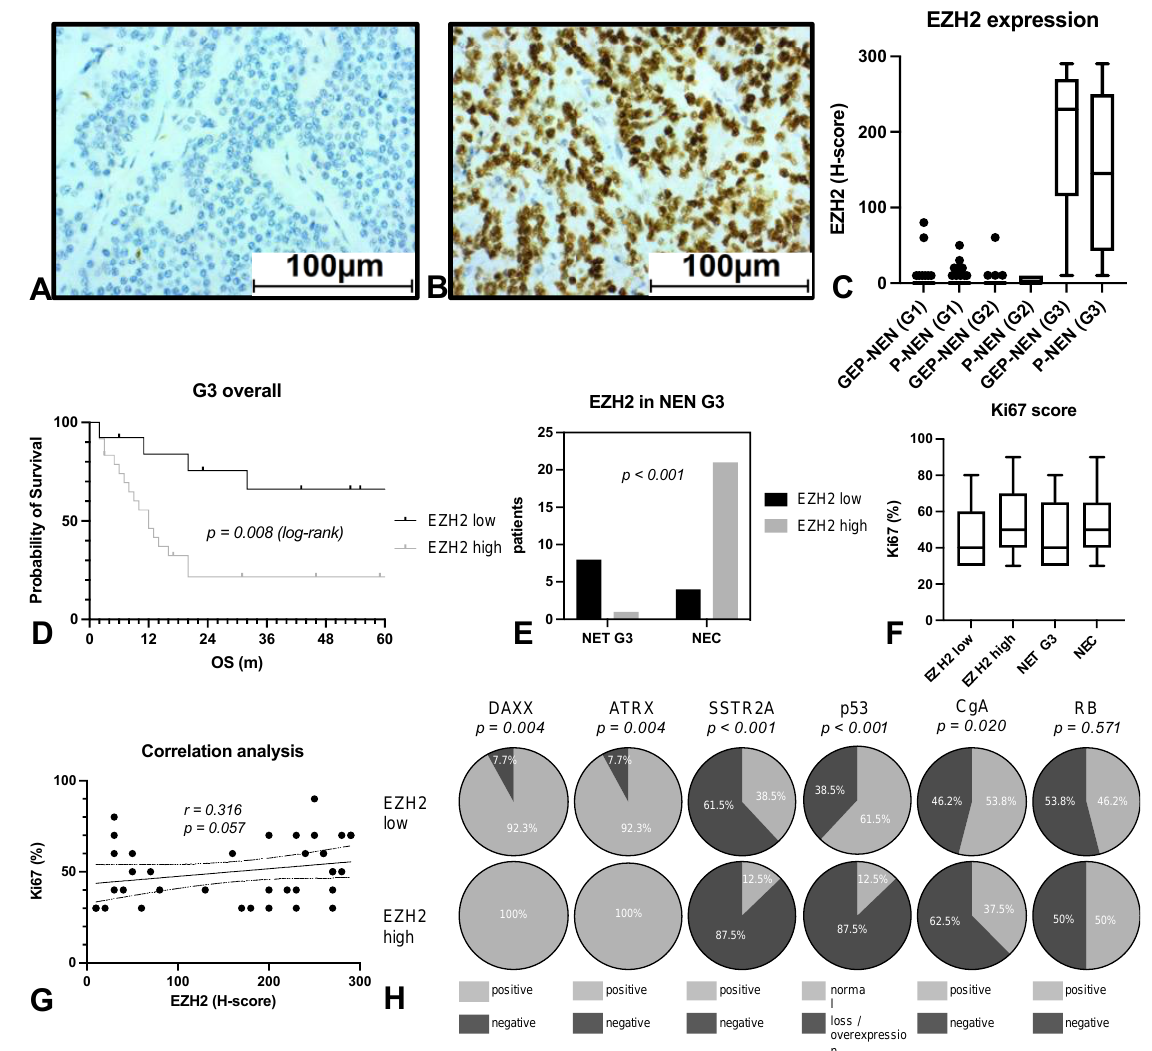
Figure 3. EZH2 expression in NEN. EZH2 staining was performed in all specimens. ( A ) shows an example of very low EZH2 expression, while ( B ) shows very high expression. EZH2 expression was quantified by using the H-score and correlated with grading and entity ( C ). Overall survival (OS) in relation to EZH2 expression ( D ). The distribution of EZH2 in NET G3 and NEC samples was analyzed and calculated ( E ). The distribution of Ki67 in tumors with low or strong EZH2 expression and in NET G3 and NEC and the direct correlation of EZH2 and Ki67 were analyzed ( F , G ). Correlation of conventional marker of NEN G3 and EZH2 expression ( H ). GEP: gastroenteropancreatic, NEN: neuroendocrine neoplasia, OS: overall survival, P: